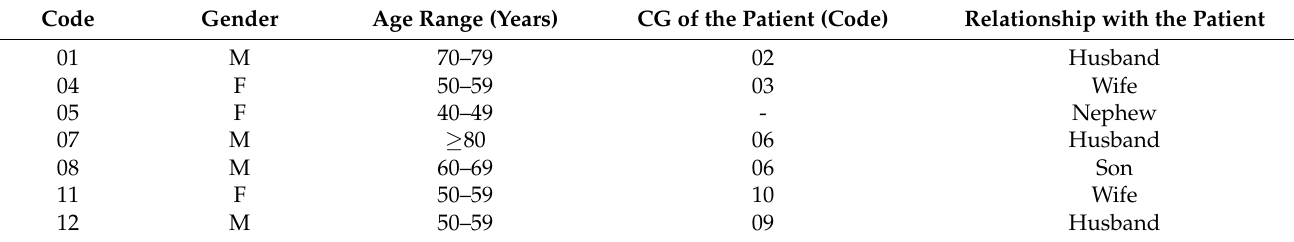
Table 3. Characteristics of CGs (n = 7).